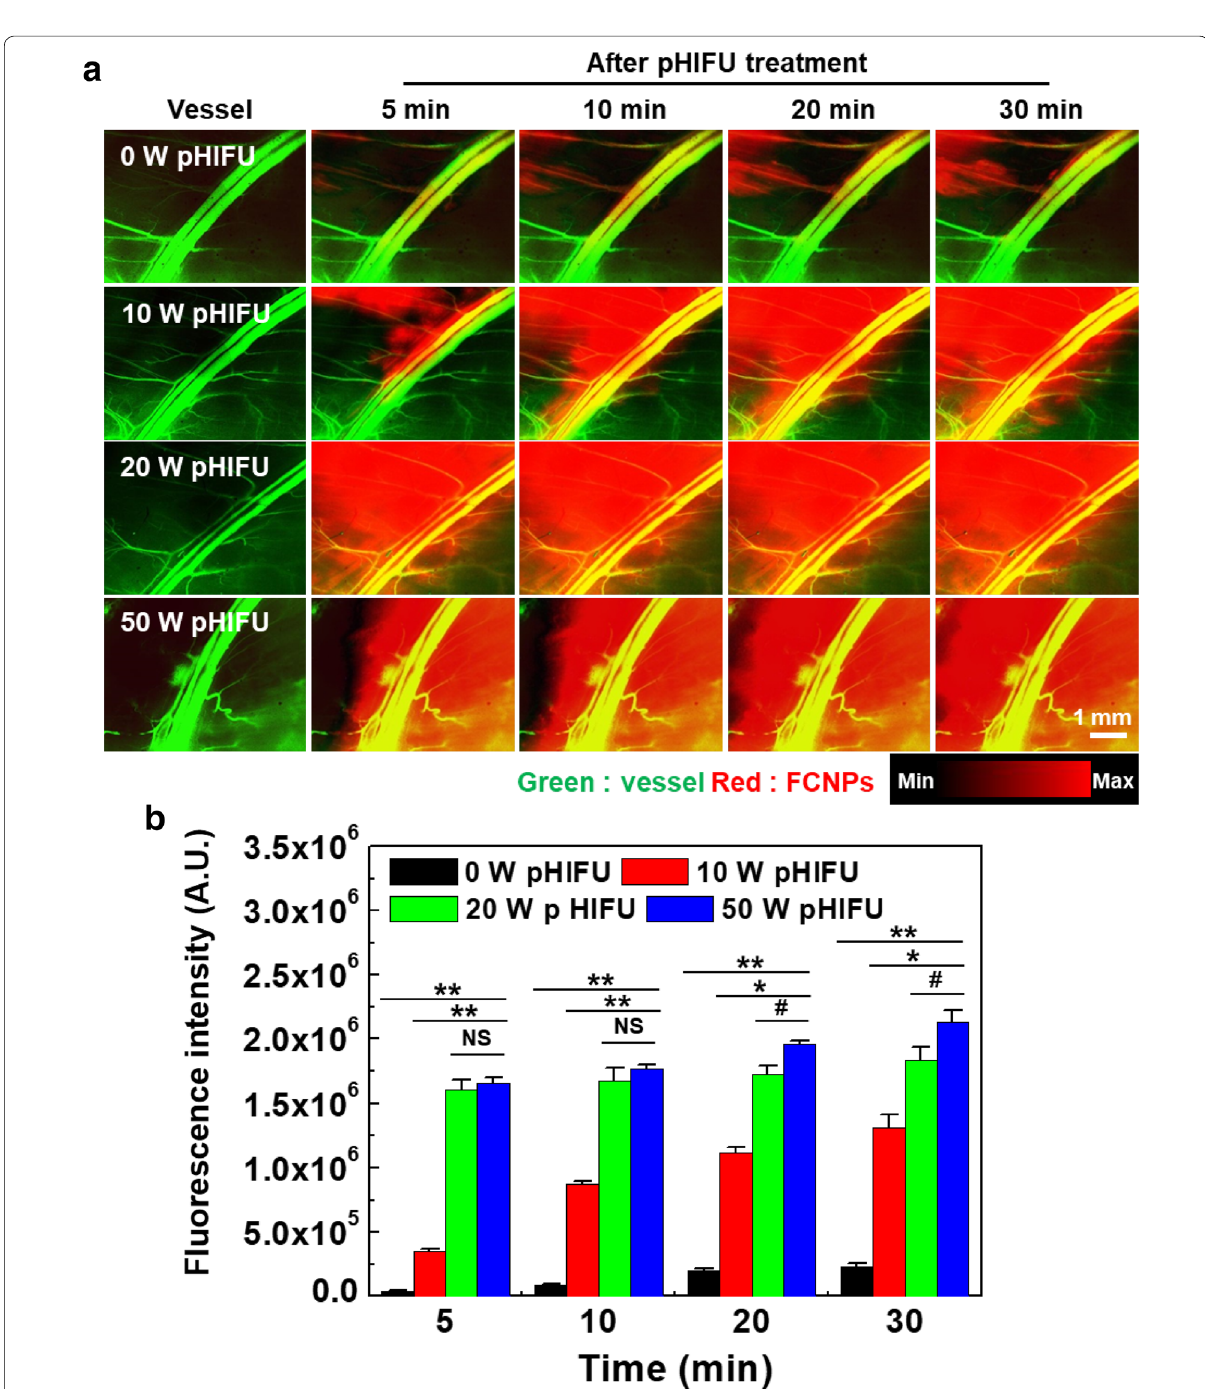
Fig. 4 pHIFU-mediated tissue penetration effect of FCNPs using in vivo NIRF imaging system. a Fluorescence images of femoral tissues, which intra- venously injected FCNPs followed by 10, 20, and 50 W pHIFU treatment. Scale bar indicates 1 mm. b Quantified fluorescence intensity of FCNPs in femoral tissues. # , *, and ** indicate difference at the p < 0.05, p < 0.01, and p < 0.001 significance level,